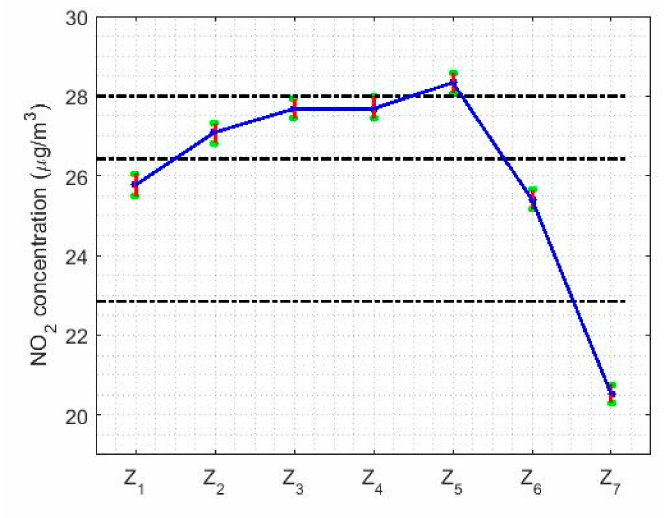
Figure 13. 95% nonparametric confidence intervals for the medians: Z 1 (Monday), Z 2 (Tuesday), Z 3 (Wednesday), Z 4 (Thursday), Z 5 (Friday), Z 6 (Saturday), and Z 7